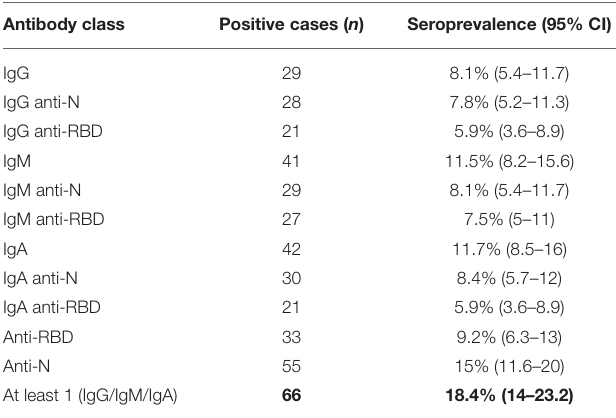
TABLE 2 | Seroprevalence of anti-SARS-CoV-2 antibody classes and specificities. Antibody class